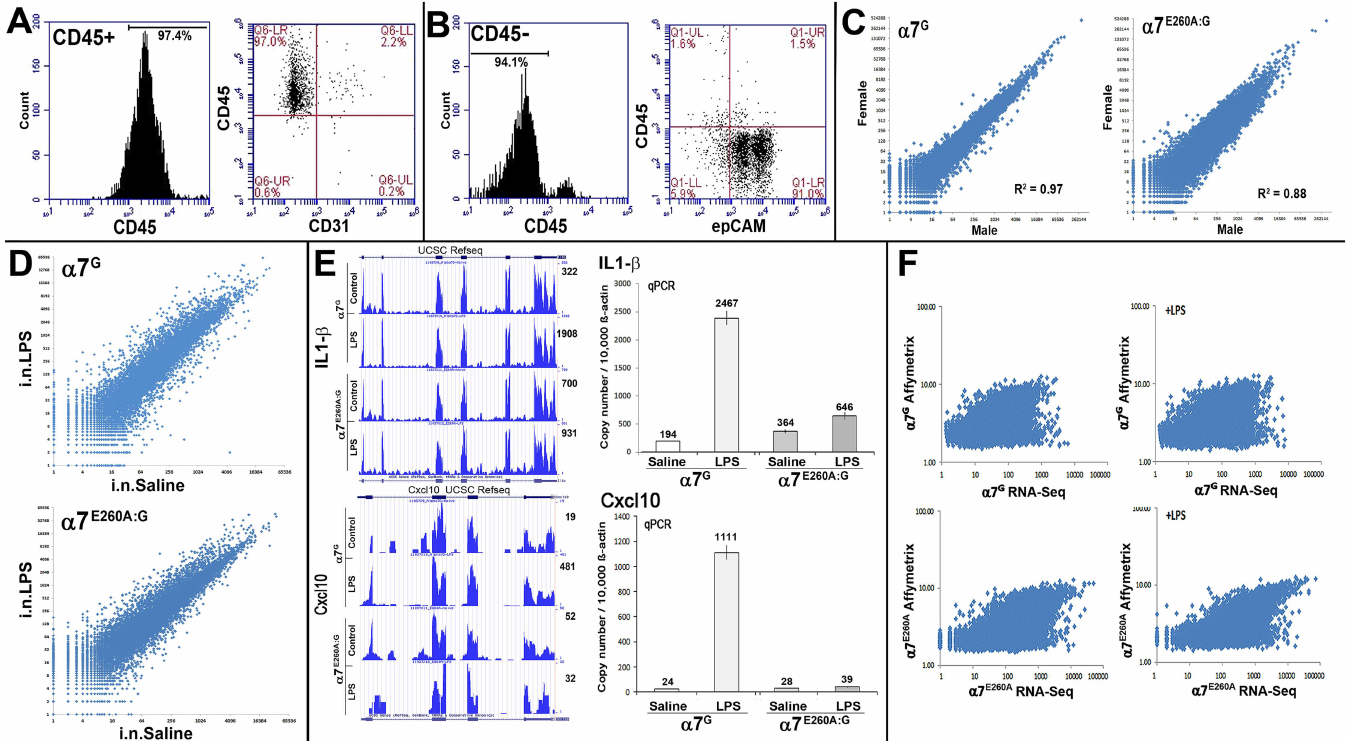
Fig 4. Isolation of CD45 - lung epithelium and characterization of RNA transcript expression. A) BALF was collectedfrom groups of 3–5 mice, pooled, and blocked with anti-CD16/CD32 antibodies(FcR γ ) to prevent non-specific binding.These cells were then stained with monoclonal antibodiesdirected against mouse CD45 (marker of bone marrow derived cells) and CD31(endothelial cell marker) and analyzedusing flow cytometry. In the BALF 97% or more of the cells were CD45+. B) The lung tissue was removed, trachea and proximal structures removedby dissection,and the remaining tissue (interstitium) was digested.These single cell suspensions Fc-blockedand stainedas aboveand describedin the Methods. Stained samples were analyzed using flow cytometry. More than 94% of the cells were CD45 - and greater than 90% were epCampositive defining epithelialcells. C) Cells from CD45 - fractions were then collectedfor each α 7-genotype, RNA preparedand RNA-Seqperformed (Methods and text). The results show a log(2) plot comparison of transcript expressionbetweenthe α 7g male-female or α 7 E260A:G male female analyses.Linear regression (R 2 ) of the results demonstrates high correspondence betweenthe respectivegendersof each genotype. D) Comparisons of RNA-Seqresults (Log(2) plots) between CD45 - distal lung cell fractions from α 7 G or α 7 E260A:G genotypes both followingexposureto intranasal saline (control) or i.n. lipopolysaccharide(i.n.LPS). E) Examples of RNA-Seq results for two genes (interleukin1- β (IL-1 β ) and chemokine Cxcl10) overlaidwith the UCSC RefSeq. The read coverage graphstaken from the UCSC browser reflect the results of raw counts (total) per sample. Becausethe library sizes for each sample were similar, differences in magnitude do not account for shifts in the reportedrelative transcript values (not shown). The quantitation(shown adjacent to the plot for each sample) after different treatments is also compared with the results of qPCR analysisfor these gene transcripts. Note the overall agreement betweenthese measures that was typical for these results. Further, neither the IL-1 β or Cxcl10 gene transcript in the α 7 E260A:G lung CD45 - fraction was responsiverelative to the substantialincrease in transcriptionin the control followingLPS exposure. F) Plots comparingthe result of RNA samples analyzedby RNA-Seqversus the Affymetrix basedarray platform. Overall good agreement betweenthese methods was achievedalthoughthe expectedcompression of the dynamic range in Affymetrix samplesis evident.